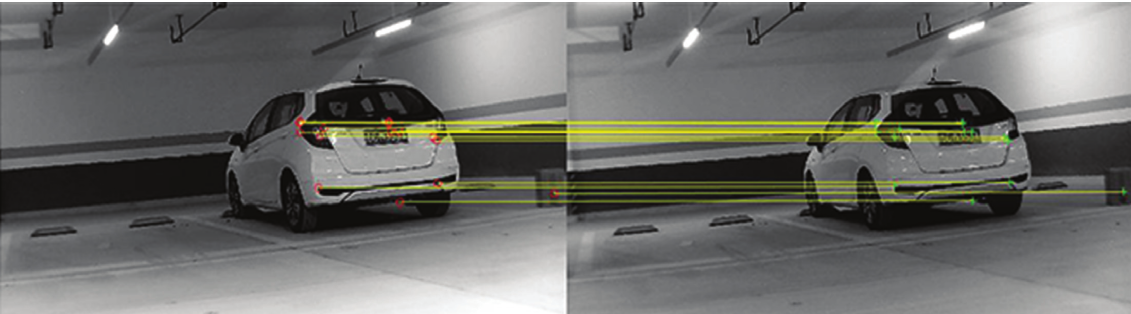
Figure 3: Feature points matching graph based on